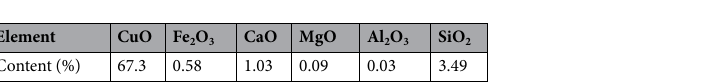
Table 4. Chemical composition of the pure malachite used in the